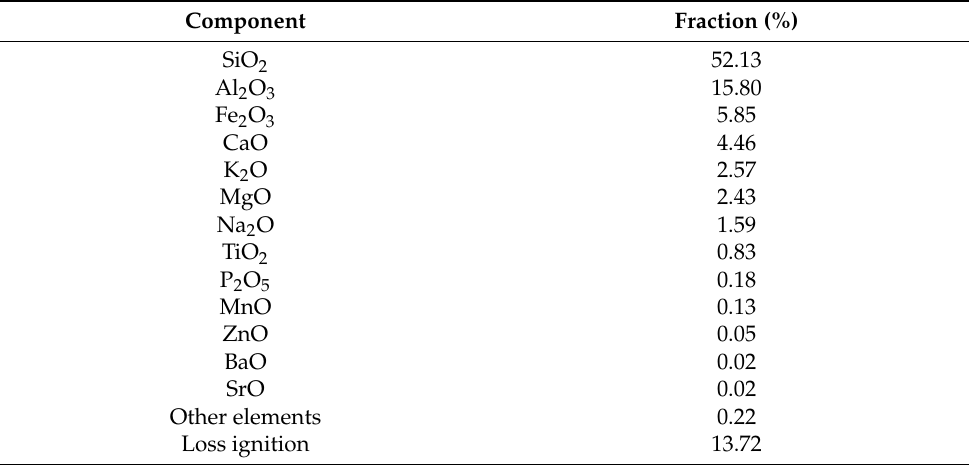
Table 2. Table 2. Chemical composition of Asian sand dust